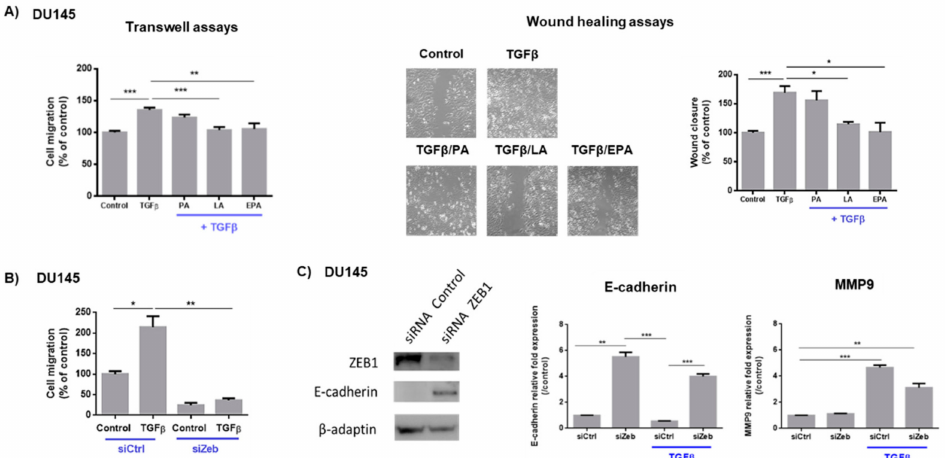
Figure 1. LA and EPA inhibit TGF β -induced-migration, which is dependent of Zeb1. ( A ) LA and EPA inhibit TGF β -induced cellular migration. DU145 cells were treated for 48 h with FA (LA, EPA, AP) (20 µ M) and with TGF β (10 ng / mL) and then used for transwell and wound healing migration assays performed for 24 h (in the presence of TGF β and / or FA) ( N = 3; n = 2). Results are expressed as mean ± SEM. Statistical di ff erences are indicated: * p < 0.05; ** p < 0.01; *** p < 0.001 (Kruskal–Wallis; post-test: Dunn’s test). The scale of the photos is × 200 magnification. ( B ) Zeb1 is required for promigratory e ff ect of TGF β . siRNA-transfected cells (siCtrl, siZeb1) were treated for 48 h with TGF β (10 ng / mL) and then used for transwell migration assay performed for 24 h (in the presence of TGF β ) ( N = 3; n = 2). * p < 0.05; ** p < 0.01 (Kruskal–Wallis; post-test: Dunn’s test) ( C ) E ff ects of inhibition of Zeb1 expression on epithelial-to-mesenchymal transition (EMT) markers. siRNA-transfected DU145 cells (siCtrl, siZeb1) were treated or not for 48 h with TGF β (10 ng / mL). qPCR results (mean ± SEM) are expressed in 2 - ∆∆ Ct . ( N = 3; n = 3). Statistical di ff erences are indicated: ** p < 0.01; *** p <